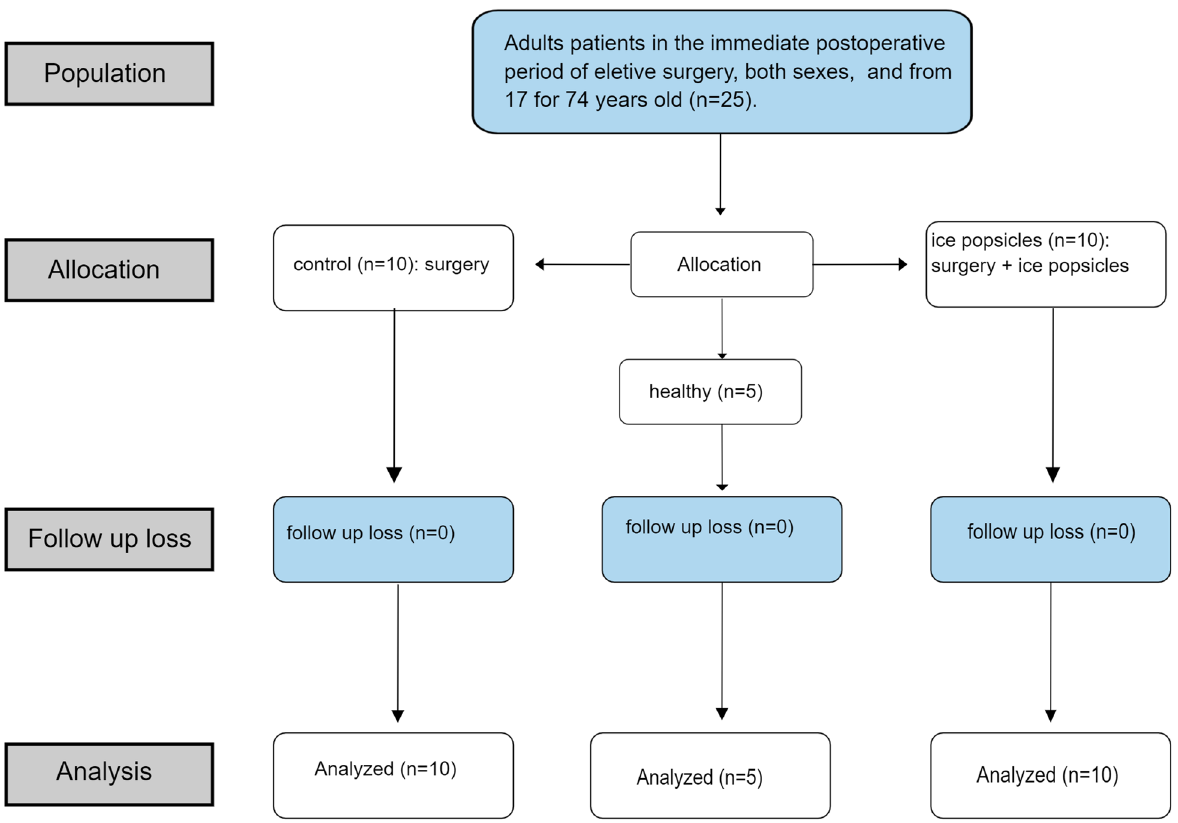
Figure 1. Diagram of sampling and definition of